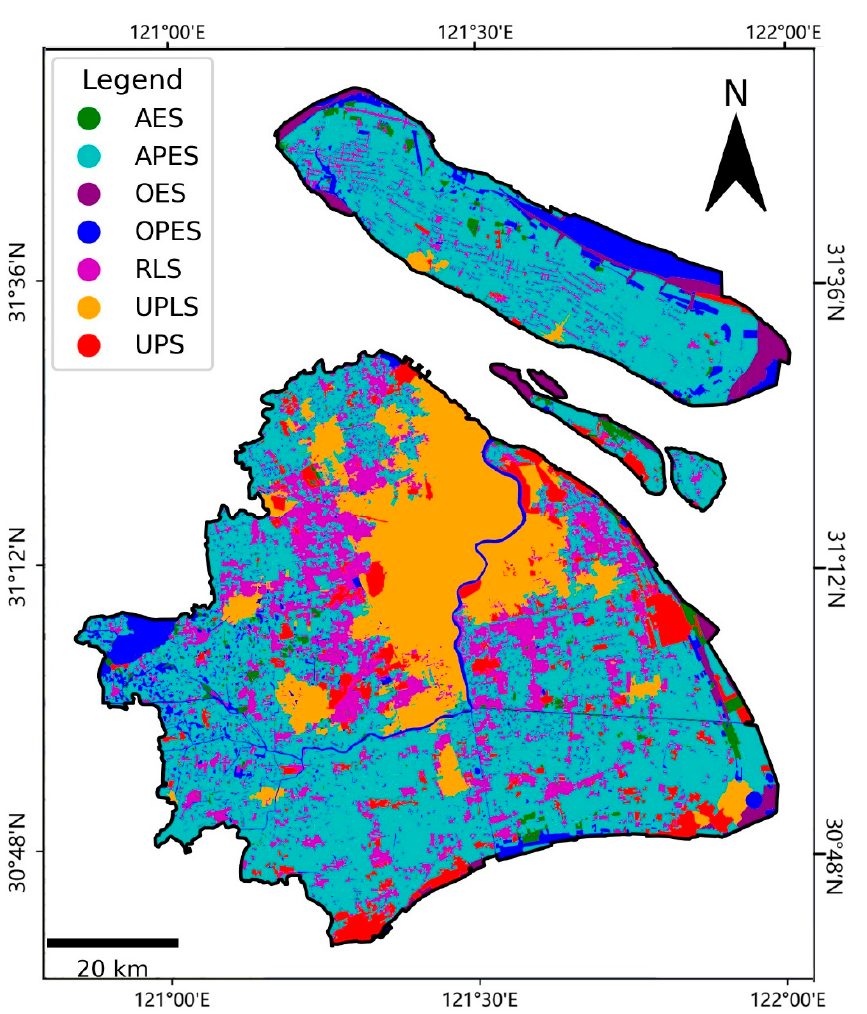
Figure 4. Urban space division based on the “production, living and ecology” land use frame- work.